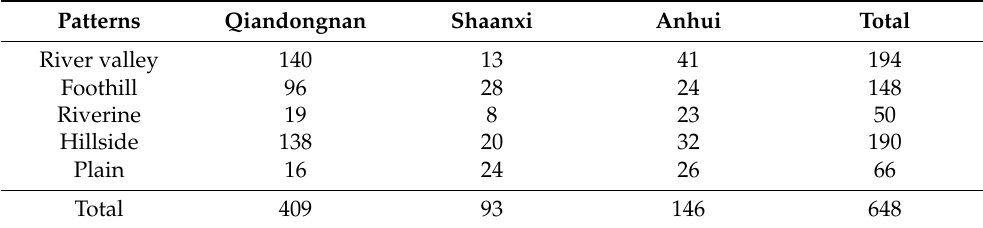
Table 1. The number of TCSs for each environmental pattern in the three areas.